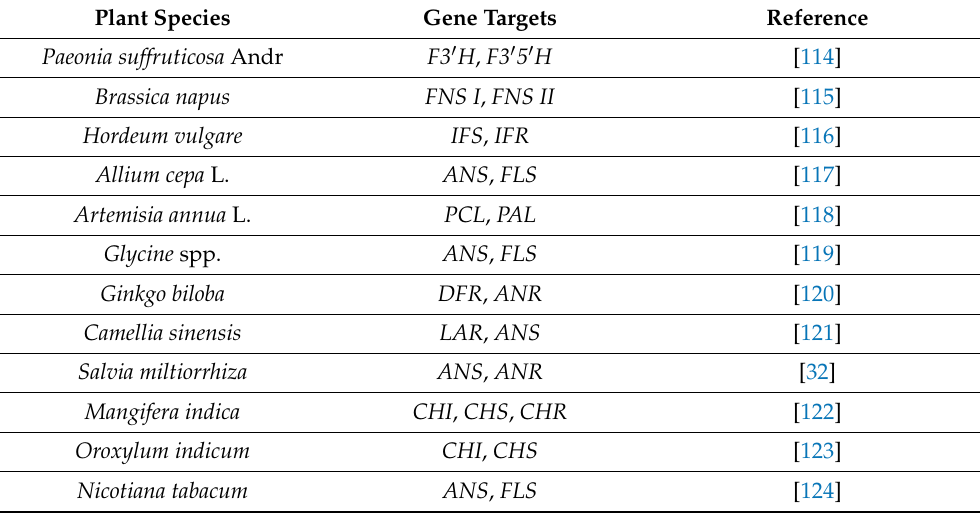
Table 3. Potential gene targets for metabolic engineering in plant flavonoid biosynthesis